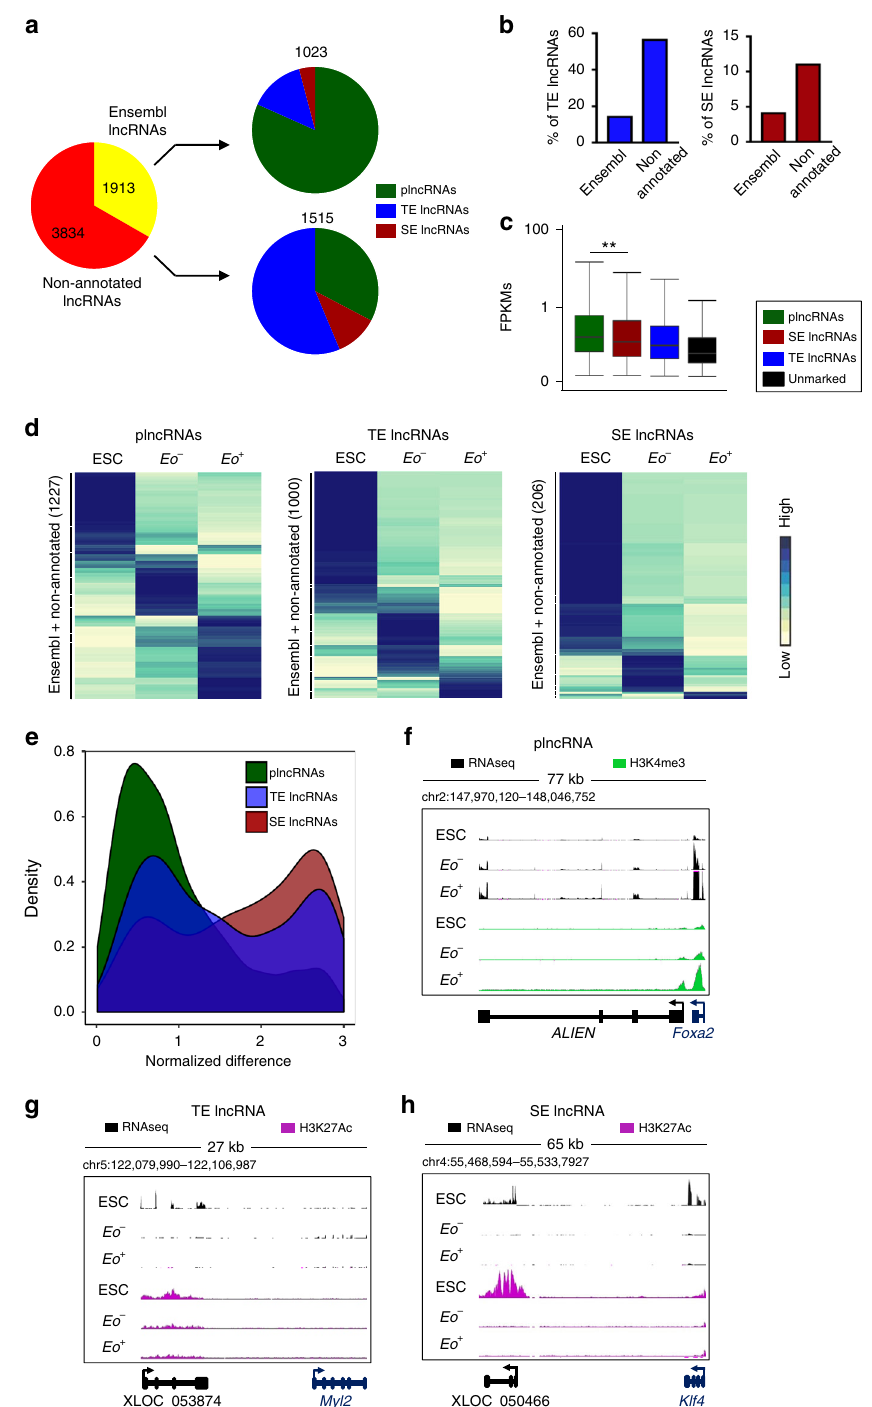
Fig. 4 Identi fi cation and characterization of promoter, typical and super enhancer associated long noncoding RNAs during mesendoderm speci fi cation. a Pie chart showing distribution of Ensembl (yellow) and non-annotated (red) lncRNAs associated with a canonical promoter signature (H3K4me3, green), typical enhancer signature (blue) or super enhancer signature (dark red). b Percentage of TE lncRNAs (blue) and SE lncRNAs (dark red) in Ensembl and non-annotated lncRNAs. c Box plot whiskers of transcript abundance (FPKM) of plncRNAs (green), SE lncRNAs (dark red), TE lncRNAs (blue) and unmarked lncRNAs (black). Box plot whiskers show median value and 10 – 90 percentiles. p values were calculated using a two-tailed t test. (** P < 0.01). d Hierarchical clustering of plncRNA, TE lncRNA and SE lncRNA expression across ESC, Eo − and Eo + . e Kernel density plot of the speci fi city of plncRNAs, TE lncRNAs and SE lncRNAs assessed by quantifying the Normalized difference of expression in the three conditions (ESC, Eo − , Eo + ). f RNAseq and H3K4me3 reads in ESCs, Eo − and Eo + cells for example plncRNA ( ALIEN ). g RNAseq and H3K27Ac reads in ESCs, Eo − and Eo + cells for example TE lncRNA ( XLOC_053874 ). h RNAseq and H3K27Ac reads in ESCs, Eo − and Eo + cells for example SE lncRNA ( XLOC_050466